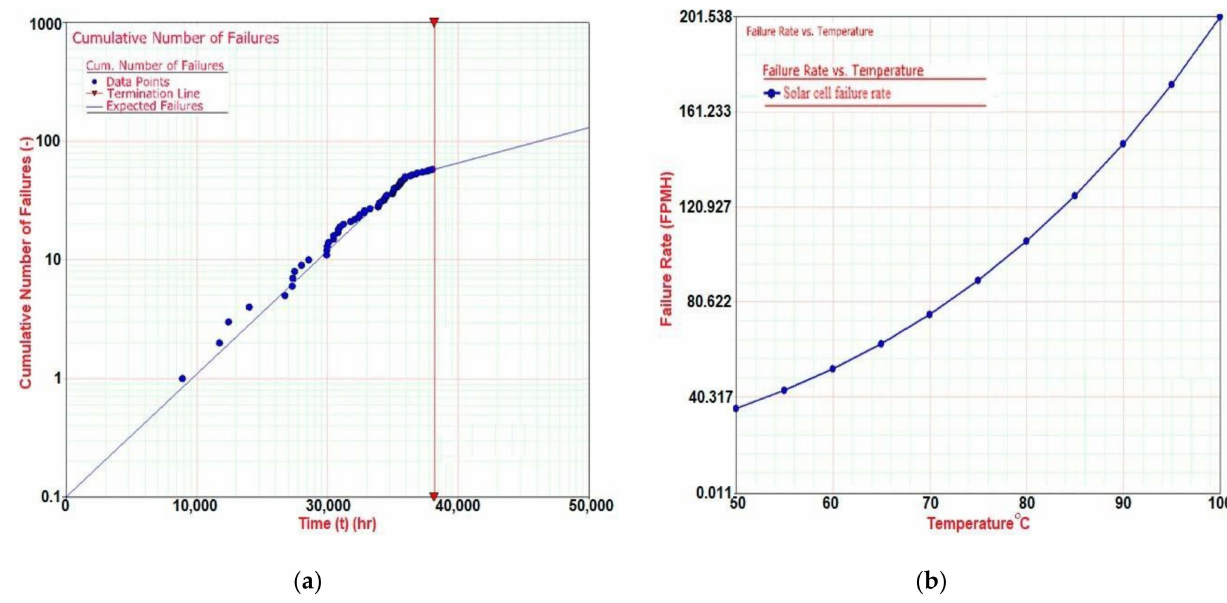
Figure 22. ( a ) Cumulative number of failures as function of time (using ALTA module). ( b ) Baseline survival of solar cell simulation (using ALTA module) at temperature and stress conditions